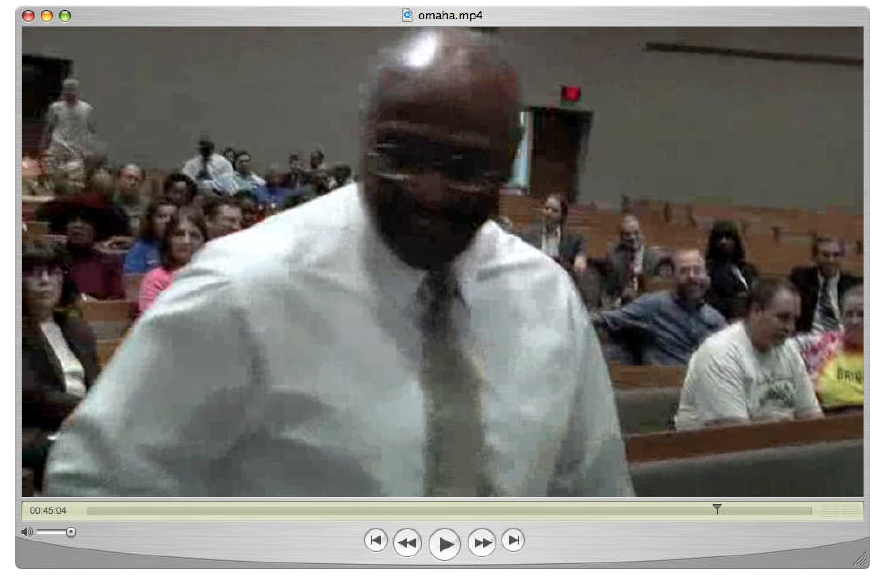
Figure 17: Shared laughter and negotiating